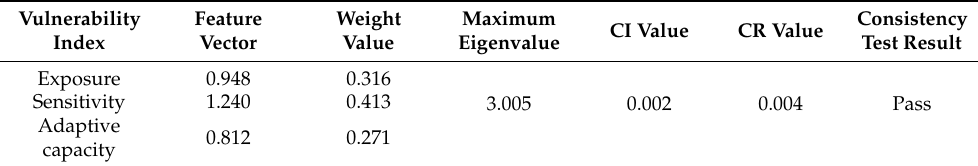
Table 5. Analytic hierarchy process results.